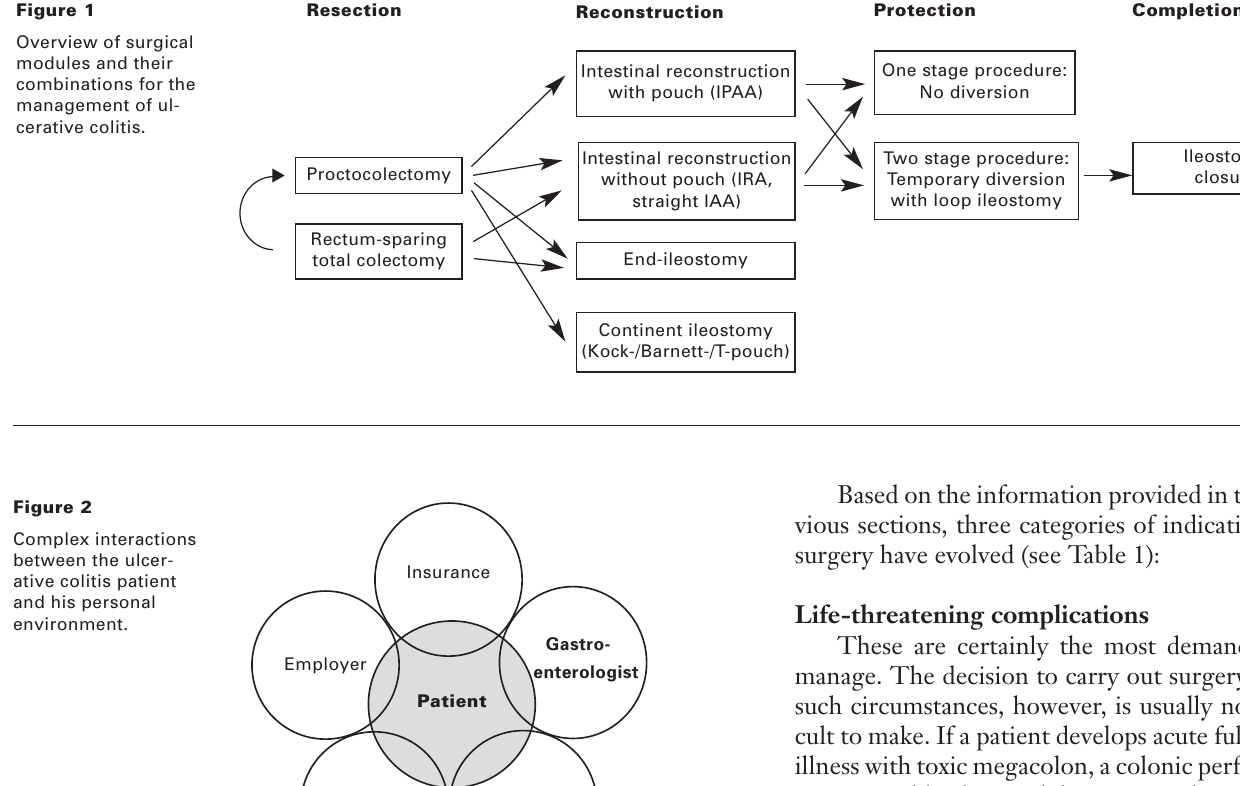
Overview of surgical modules and their combinations for the management of ul- cerative colitis.